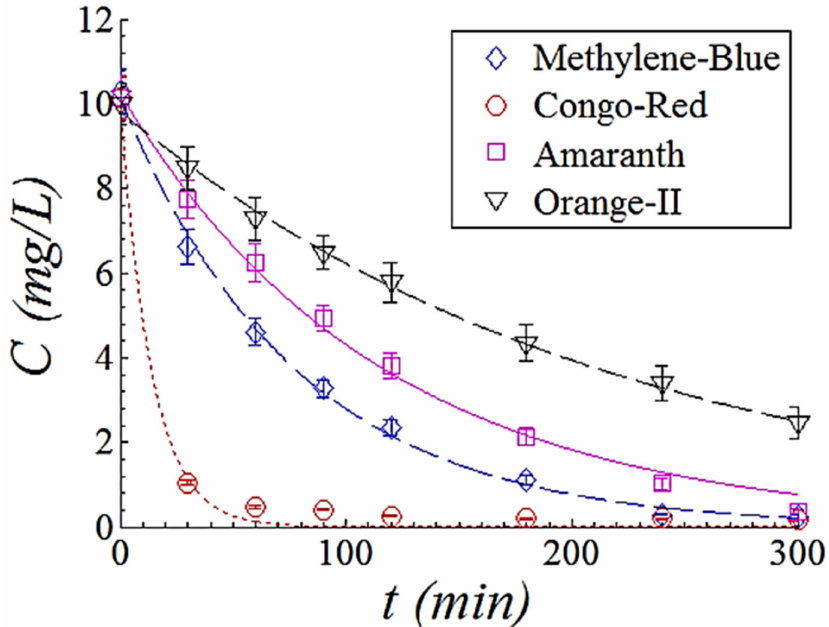
Figure 10. Comparative study showing the kinetics curves for degradation of various dyes under visible light in the presence of sample TAg1. Solid and dash lines represent predictions given by PFO kinetic model. The experimental conditions are: catalyst dosage = 0.4 g/L, T = 23 ± 2 ◦ C, pH 7.0 ± 0.2.